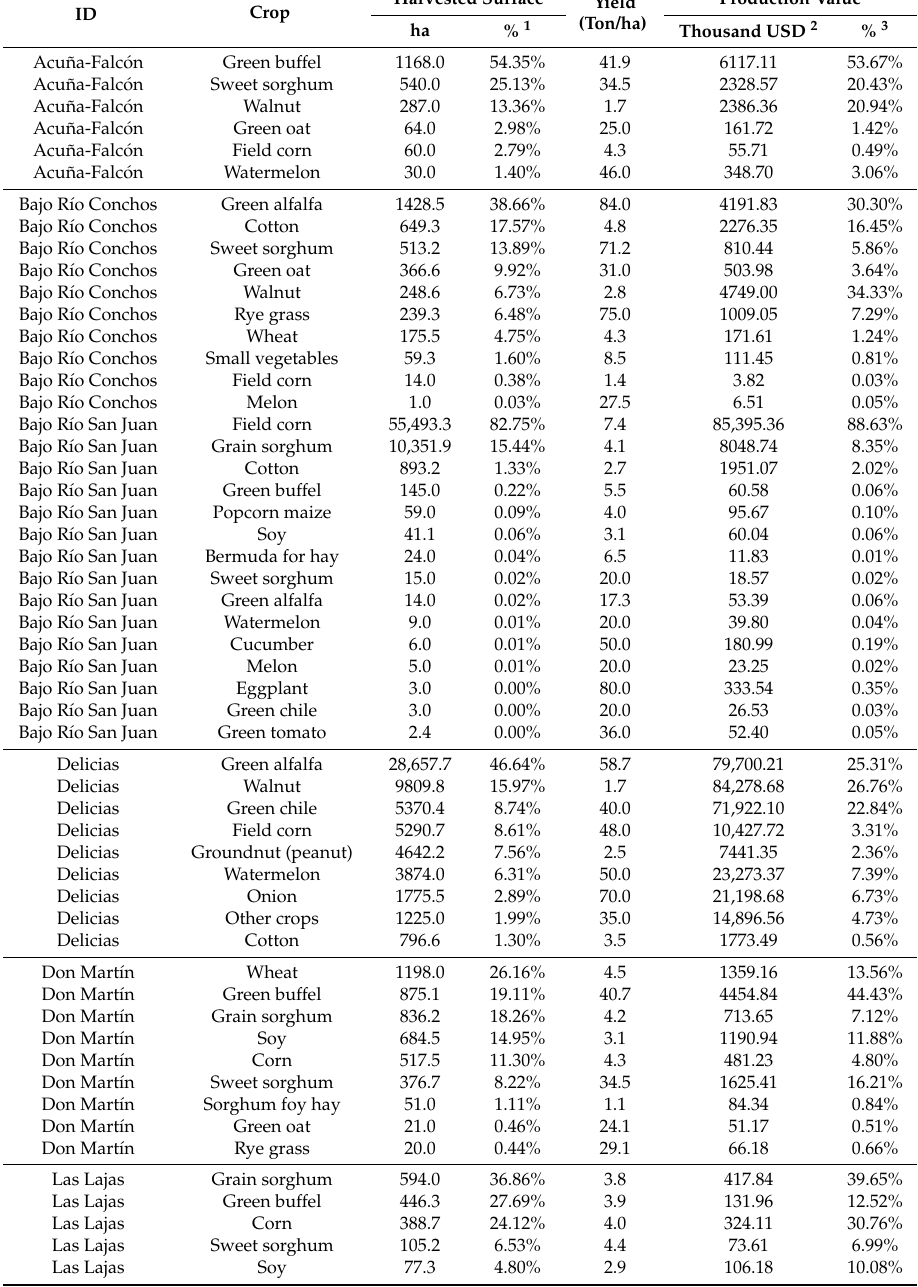
Table A1. Crops reported for the 2015–2016 period in the IDs of the Rio Bravo Basin according to harvested area, crop output, and production value in